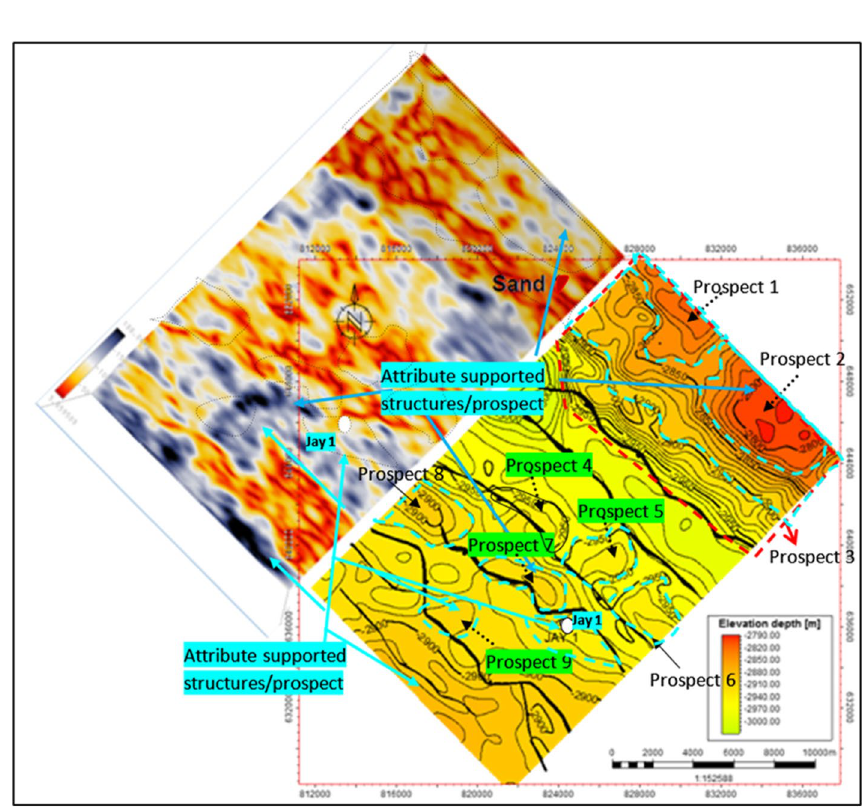
Fig. 22 Juxtaposed attribute and depth map generalised for Jay Field to integrate attribute-supported structures in prospect